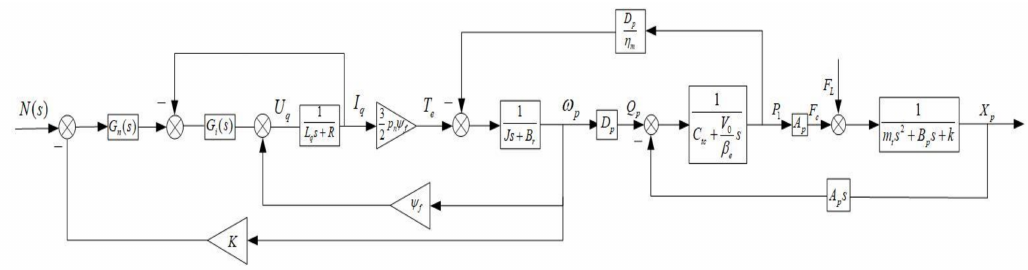
Figure 5. Electro-hydraulic servo position control system of